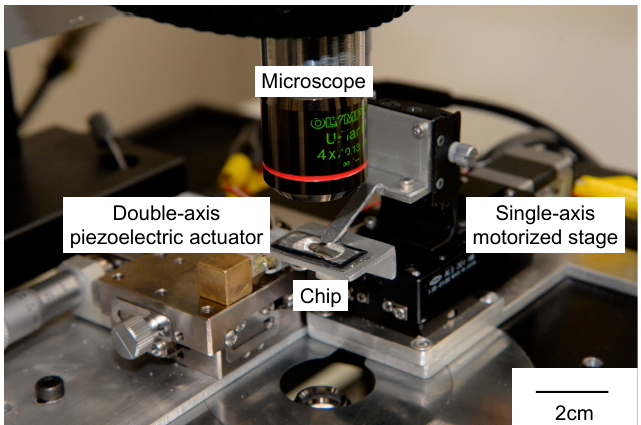
Figure 6. Experimental setup.